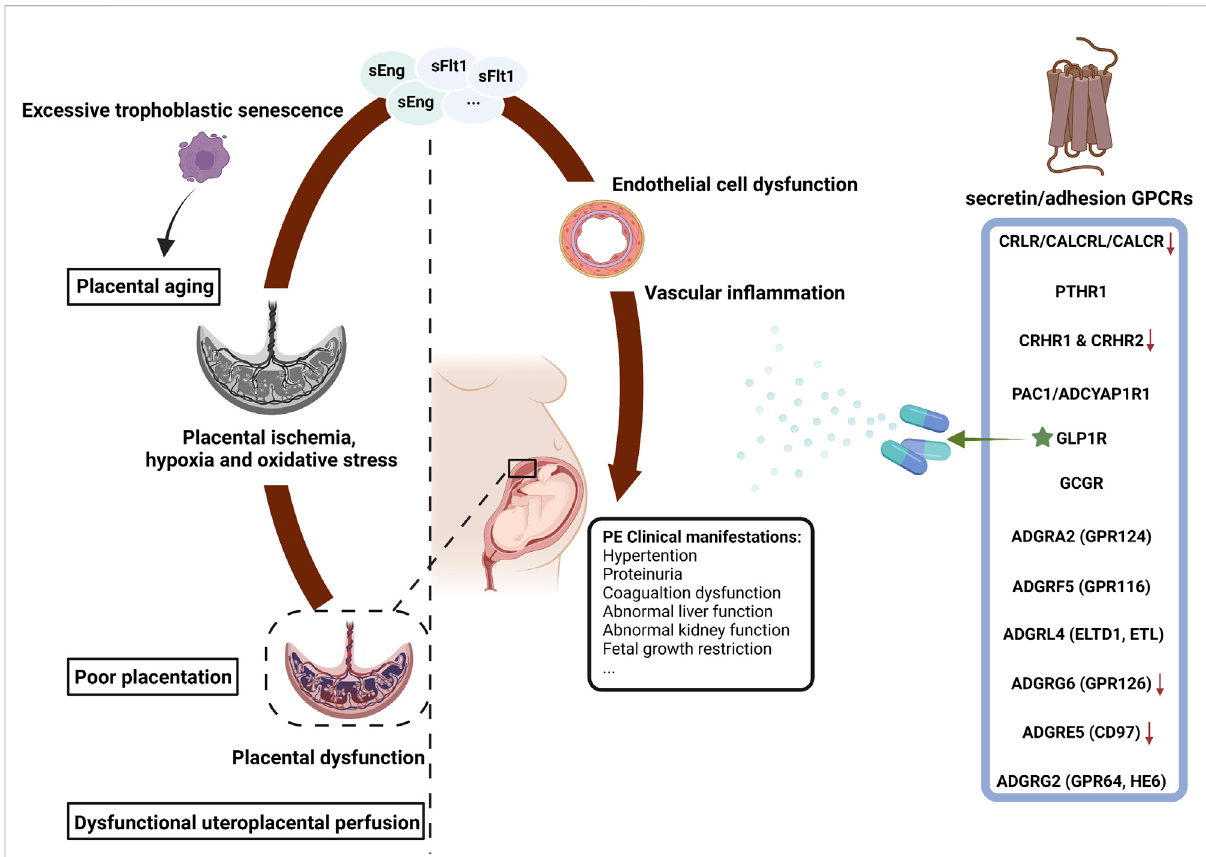
FIGURE 1 Thesecretin/adhesionGPCRsandthepathophysiologyofpreeclampsia.PE,preeclampsia;GPCRs,Gprotein-coupledreceptors;sFlt-1,soluble fms-like tyrosine kinase 1; sEng, soluble endoglin; FGR, fetal growth restriction; + , commercial drug; ↓ , expressed at low levels in PE. The fi gure was created with